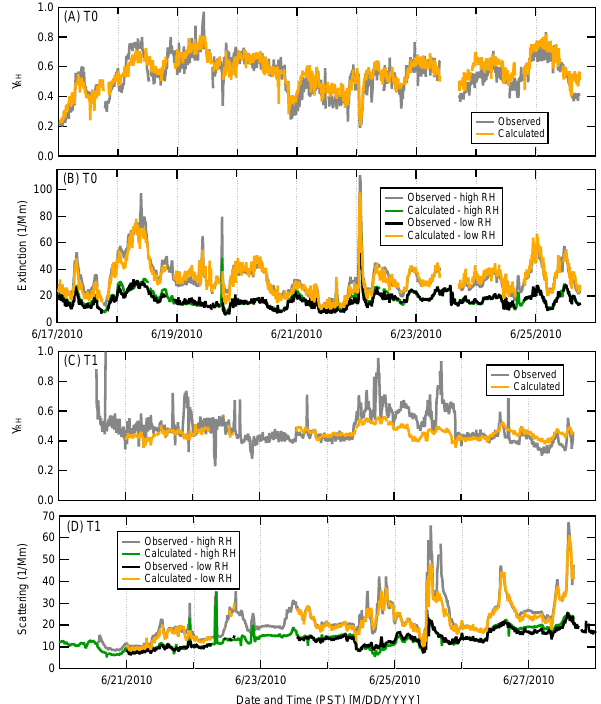
Figure 3. The time-series of the observed (gray) and calculated (or- ange) γ RH values at T0 ( a ) and T1 ( c ). The observed and calculated optical properties, b ext or b sca , for the lowest (green and black, re- spectively) and highest (grey and gold, respectively) RH channels for the CRD at T0 ( b ) and humidigraph at T1 ( d ). The calculated traces are produced by the optical hygroscopicity model described in the main